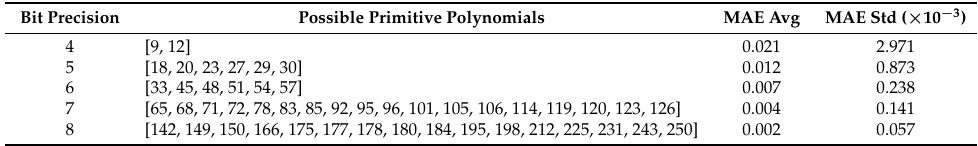
Table 2. MAE statistics for the best seeds of each polynomial sequence considering 4 to 8 bit precision. MAE was calculated for the multiplication